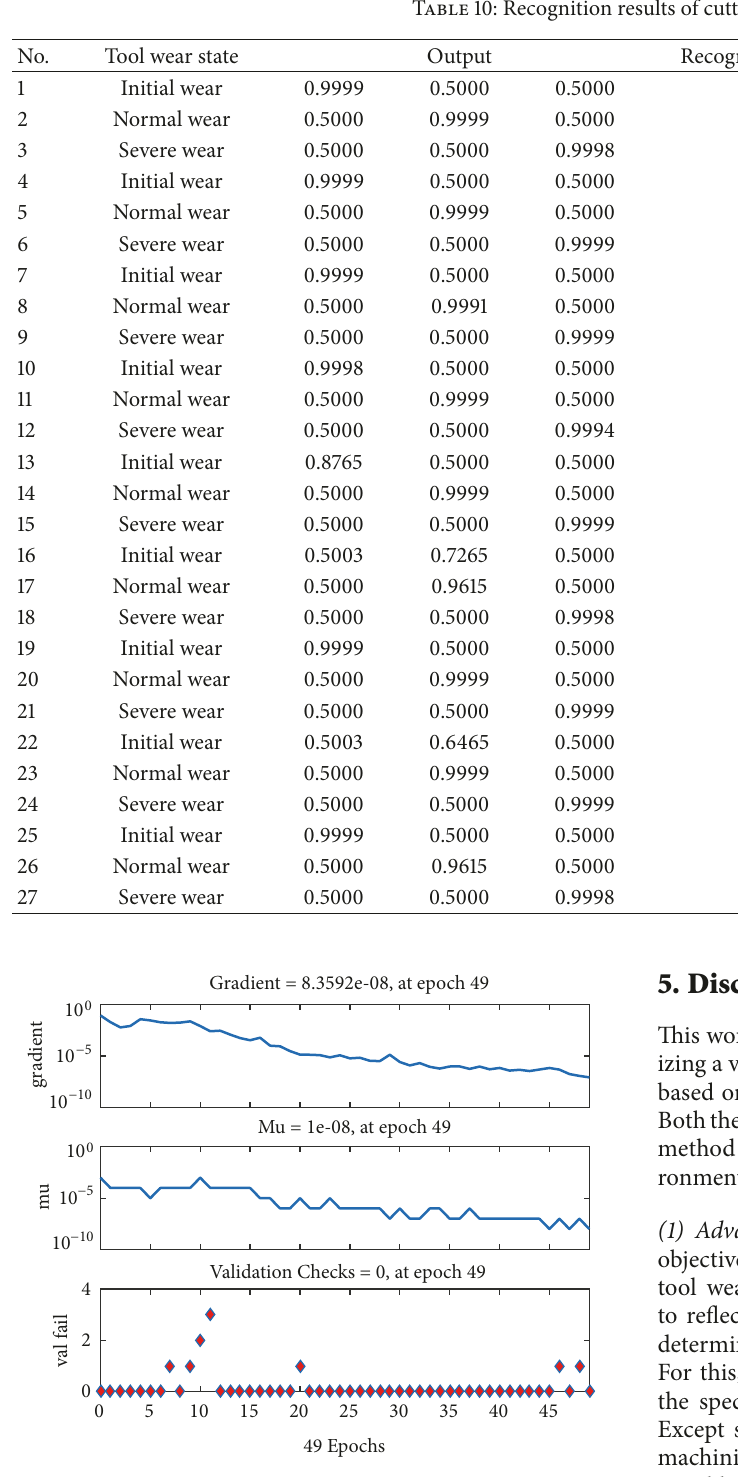
maximum, the output is [0 1 0] and the tool is in the normal wear state; and if the third number is maximum, the output is [0 0 1] and the tool is in severe wear